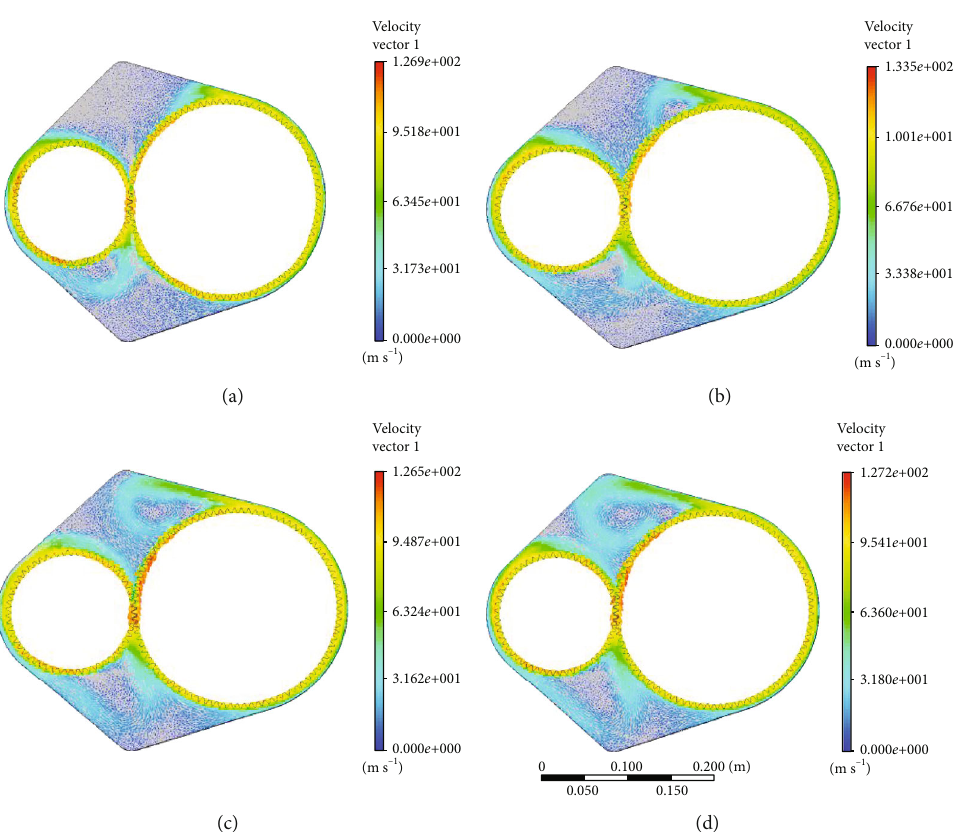
Figure 4: Velocity vector diagram of fl ow fi eld inside gearbox at di ff erent times: (a) t = 0 : 0074 s , (b) t = 0 : 0116 s , (c) t = 0 : 0167s , and (d) t = 0 : 0224 s .